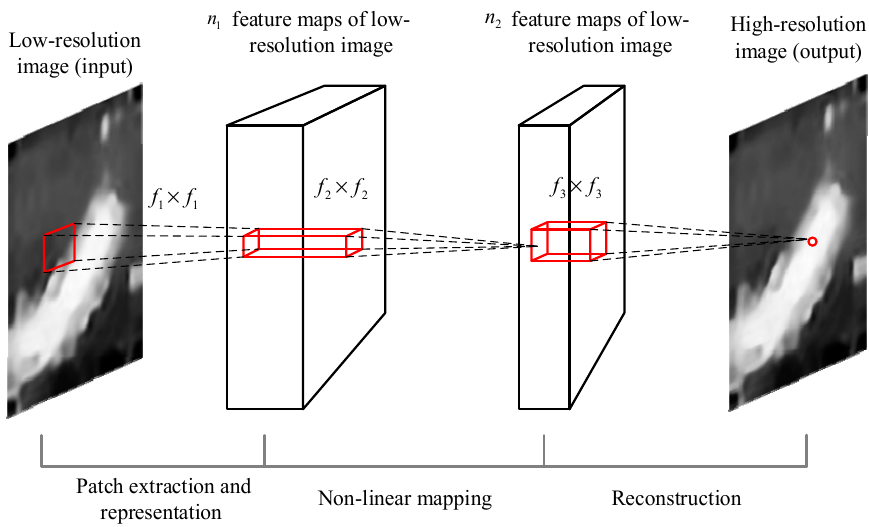
Figure 6. The Super-Resolution Convolutional Neural Network deep neural network.